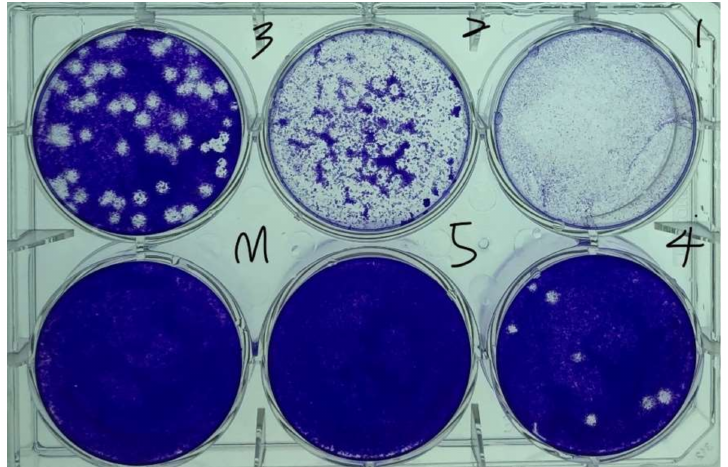
Figure 6. Cell and virus plaques in a virus plaque assay (samples 1–5 were obtained through a 10-fold dilution of the original virus